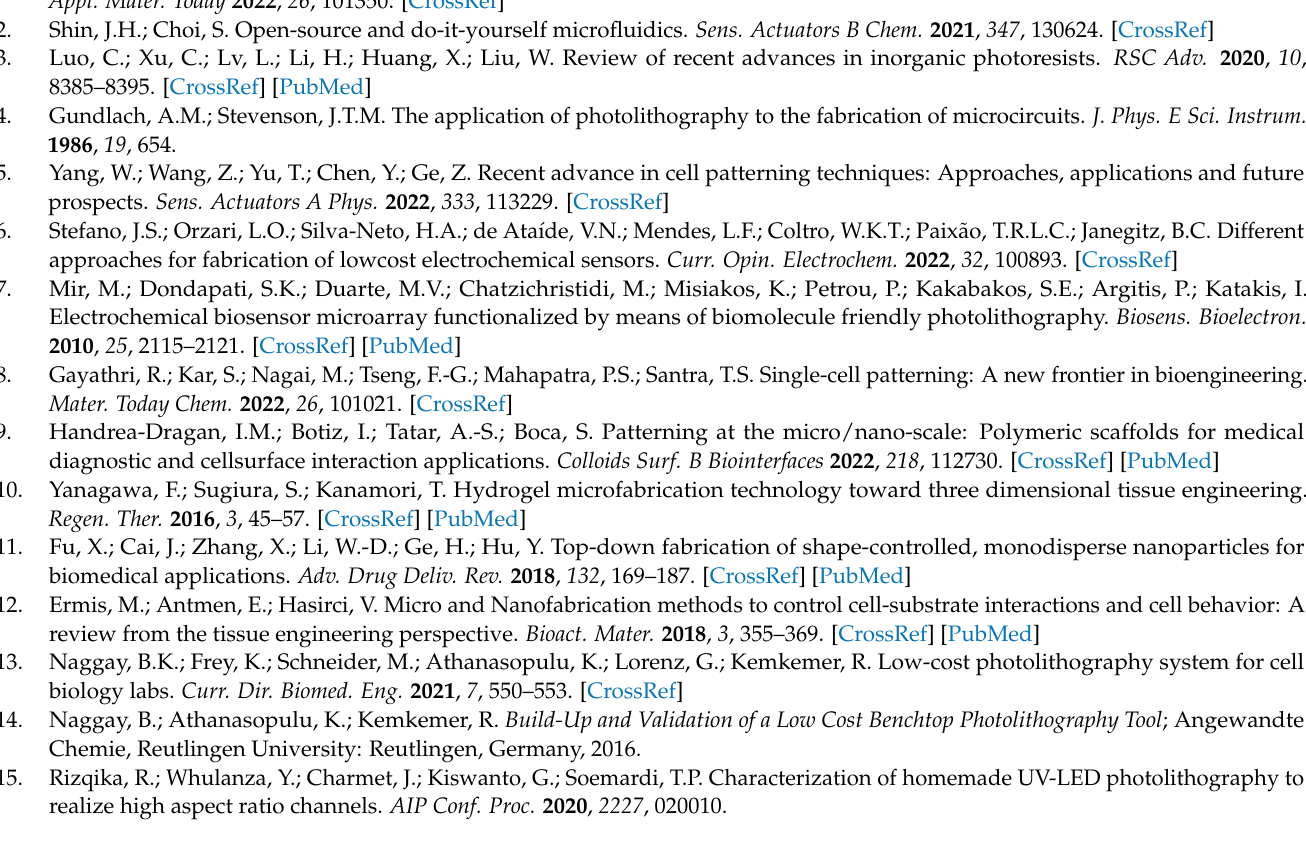
Figure S2: UV Light Holder CAD drawing; Figure S3: Bottom wafer holder CAD drawing; Figure S4: Top wafer holder CAD drawing; Figure S5: Calculating curing times and verifying the quality of the UV light exposure with the UV intensity meter in the UV containment unit; Figure S6: User-friendly chart for identifying the proper curing time according to the user’s desired outcome; Figure S7: Cross-sections of (A) ABM 3000HR Mask Aligner and (B) DUV’s T-Junction microfluidic devices. Edge quality of the produced microstructures are highlighted by the cross-section images. (Scale bar = 100 µ m); Figure S8: The droplet diameter coefficient of variation between the DUV Light System and ABM 3000HR Mask